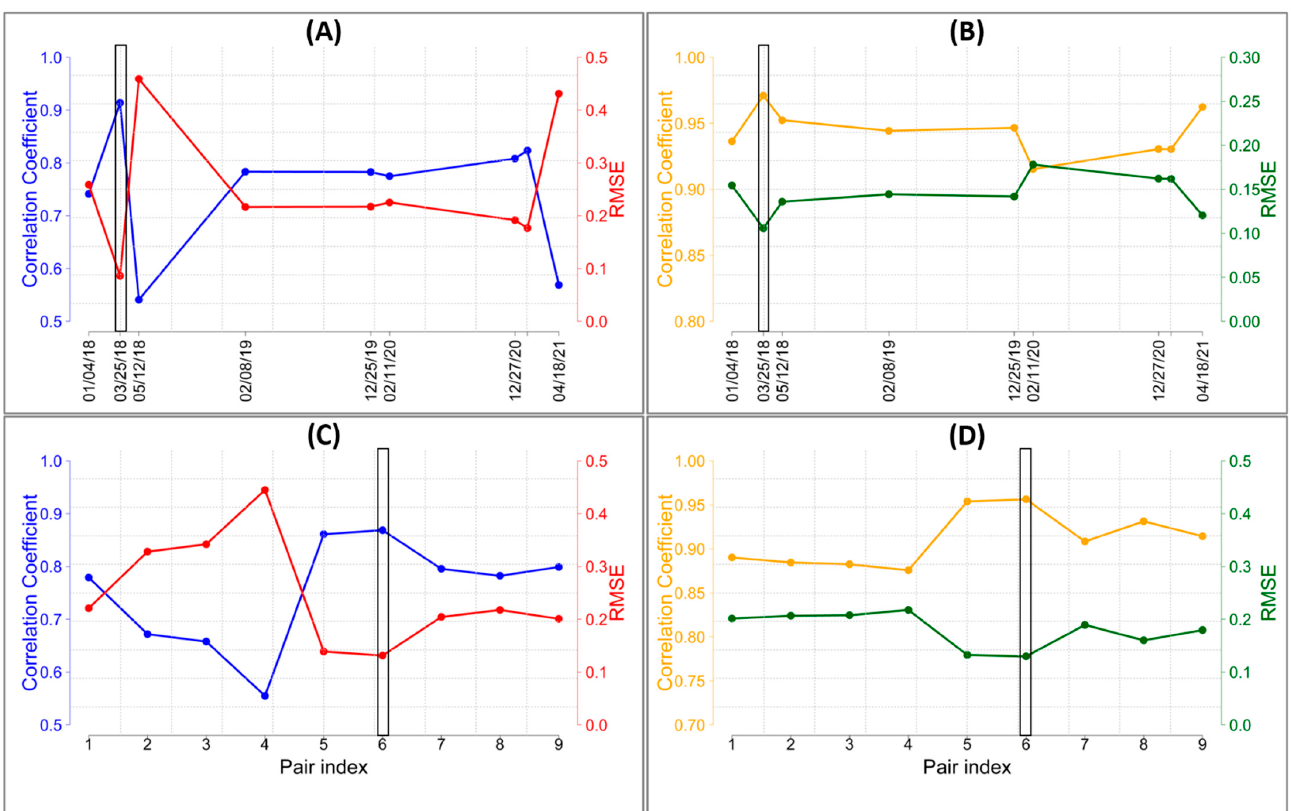
Figure 7. Correlation coefficient and RMSE between the NDSI L8 image at the prediction date and the other input image pairs at different dates for the FSDAF ( A ) and ESTARFM ( C ) models. Correlation coefficient and RMSE between the original NDSI S2 image at the prediction date and the other predicted images using different pairs as input images for the FSDAF ( B ) and ESTARFM ( D ) models.